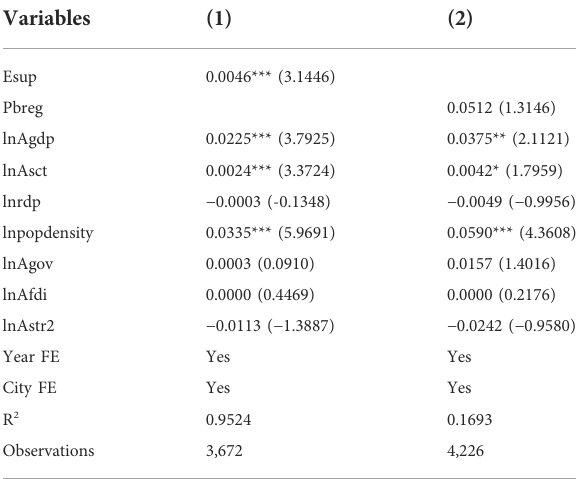
TABLE12Thein fl uenceofenvironmentalpollutionregulationandthe point-based household registration policy on environmental ef fi